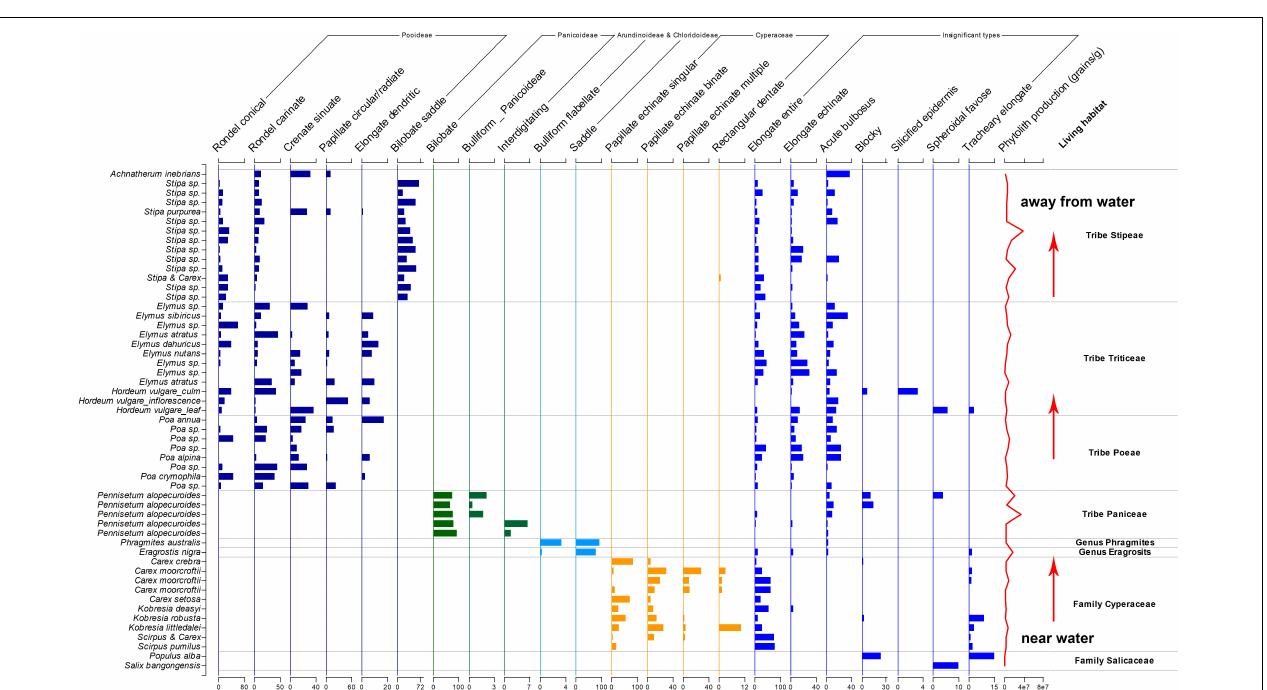
FIGURE 5 | Phytoliths morphotypes in Cyperaceae plants. 1. P APILLATE SINGULAR ; 2,5, and 8. P APILLATE MULTIPLE ; 3. R ECTANGULAR DENTATE ; 4 and 6. P APILLATE SINGULAR ; 7 and 9. P APILLATE BINATE ; and 10. B LOCKY .